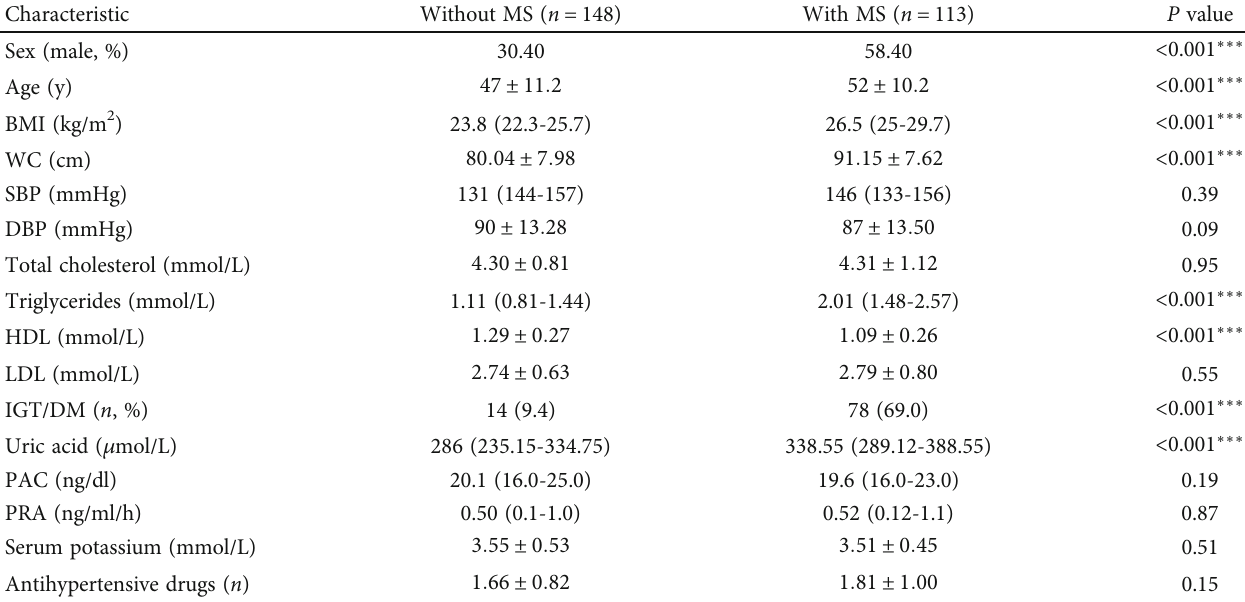
Table 1: The clinical and biochemical baseline of the PA patients with or without MS.